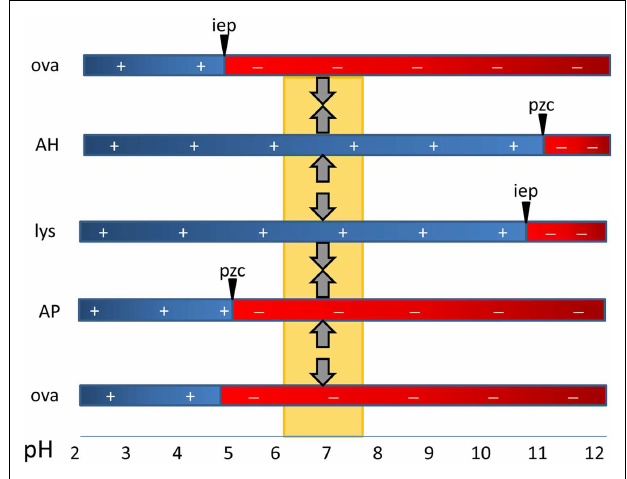
FIGURE 1 |The critical role of the type of aluminum adjuvant and pH in the adsorption of vaccine antigens via electrostatic mechanisms. The point-of-zero-charge (PZC) of aluminum hydroxide adjuvant (AH) is 11.4 and that of aluminum phosphate adjuvant (AP) is approximately 5. At the pH of vaccine formulations (about 6–7.5), AH has a positively charged surface and attracts negatively charged proteins such as ovalbumin with a isoelectric point of 4.6.The surface of AP is negatively charged and it repels similarly charged proteins (OVA) and binds proteins with a high i.e.p. such as hen egg lysozyme